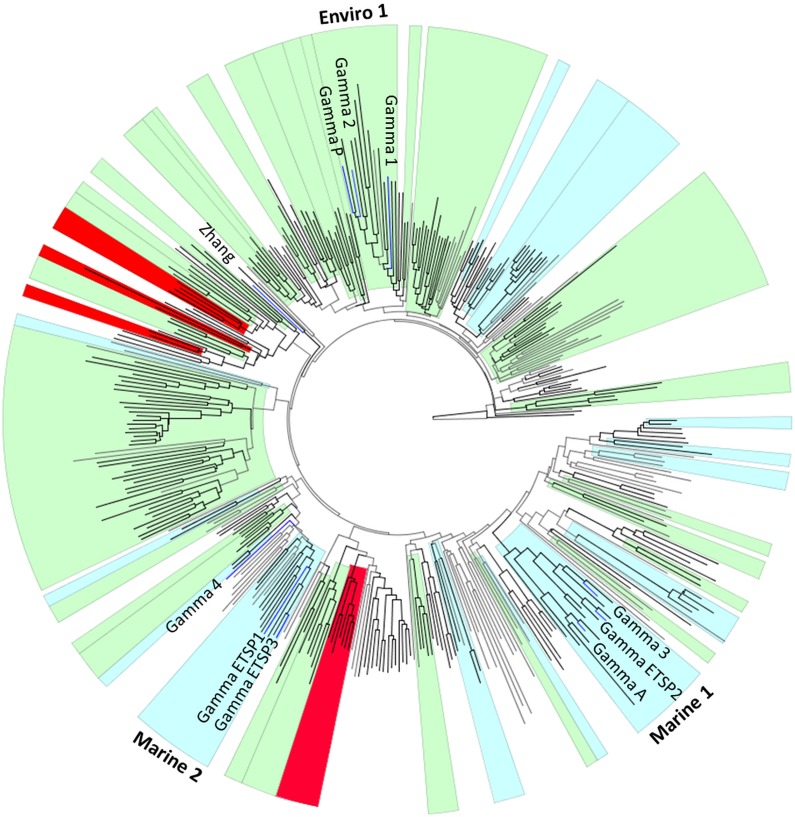
Maximum likelihood tree of γ-proteobacterial nifH OTUs.To improve visibility only OTUs ≥3 sequences are shown (400 of 1492 OTUs) and sequences names are not displayed (see S4 Fig for the sequence names). Clades of uncultured sequences from marine environments are shaded blue and from a variety of environments are shaded green. Clades containing several qPCR target sequences are labeled. Clades encompassing sequences isolated from PCR reagents are colored red. Probes used in qPCR studies are labeled and include Gamma 1, 2, 4, P, ETSP1, and ETSP3, and Zhang (S2 Fig). Tree was constructed using neighbor joining and RAxML methods. Significant branching (agreement between both algorithms and bootstrap >60) is colored black.